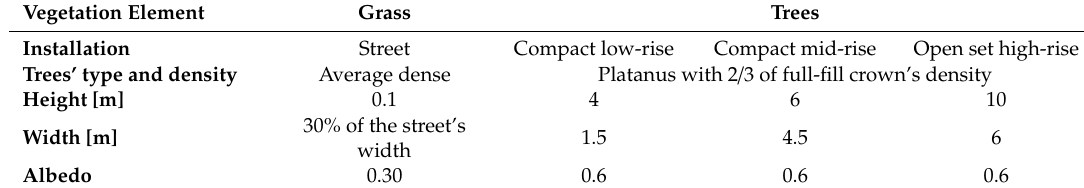
Table 8. Vegetation setting applied in the ENVI-met model.